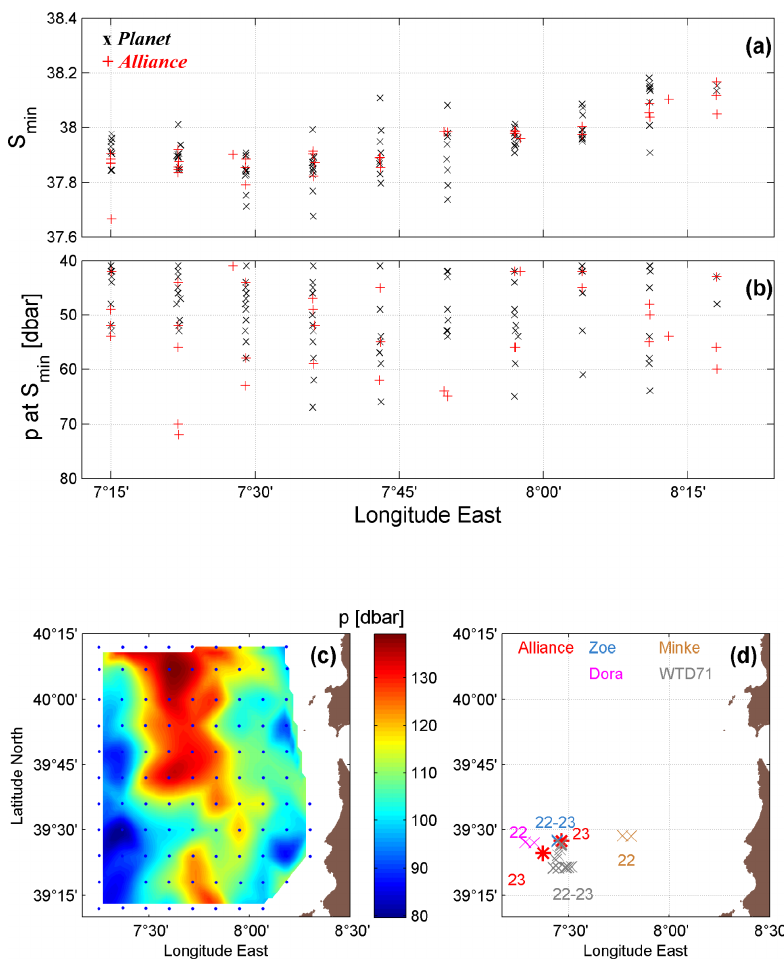
Figure 6. Characteristics of MAW, (a) salinity minimum ( S min ) within 40 to 80dbar of all Planet (x) and Alliance ( + ) CTD casts, (b) corresponding pressure ( p ) levels of S min , (c) pressure level of lower boundary of MAW ( σ (cid:50) = 28 . 72kgm − 3 ) based on Planet CTD casts, and (d) positions (symbols) and June dates (numbers) of all CTD and glider profiles with measurements of unusually low saline surface water ( S< 37 . 32 within 0 to